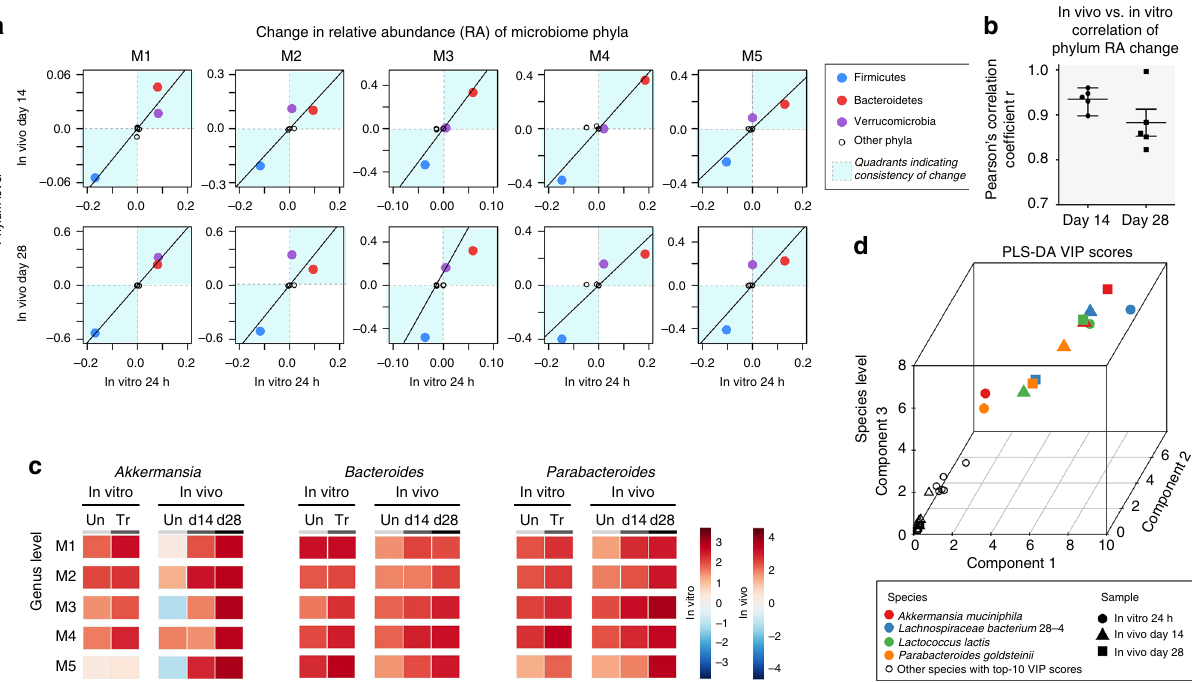
Fig. 3 In vitro – in vivo correlation of taxonomic responses to metformin treatment. a Comparison of the change in relative abundance of the major gut bacterial phyla following in vitro and in vivo (days 14 and 28) metformin treatment of individual HFD-fed C57/BL6 wild-type litter-mate mice. Data point that falls into quadrants I and III (in blue background) indicates in vitro – in vivo consistency in increased and decreased phyla in response to metformin, respectively. b Pearson ’ s correlation coef fi cient r between in vivo and in vitro changes of phyla in response to metformin treatment. Error bars represent the standard deviation. c Heat map showing change in relative abundance of three bacterial genera, known to increase in metformin-treated HFD-fed mice. The left panels represent in vitro cultured individual mouse microbiome in the absence or presence of metformin, whereas the right panels correspond to in vivo microbiome drug-treatment at days 14 and 28. n = 5 biologically independent mice. d Comparison of variable importance in projection (VIP) on the fi rst three components from three separate PLS-DA analyses. PLS-DA analyses were performed by comparing untreated microbiome versus microbiome following in vivo 14-day, 28-day and in vitro 24 h metformin treatment, respectively. Four bacterial species were consistently ranked with the highest VIP scores in the three analyses. Underlying data are provided in the Source Data fi